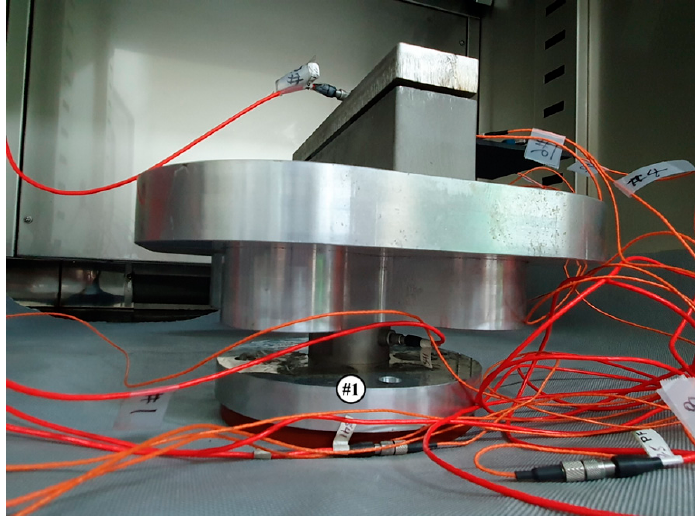
Figure 3. Location of force sensor on the CFRP specimen (ch#1).